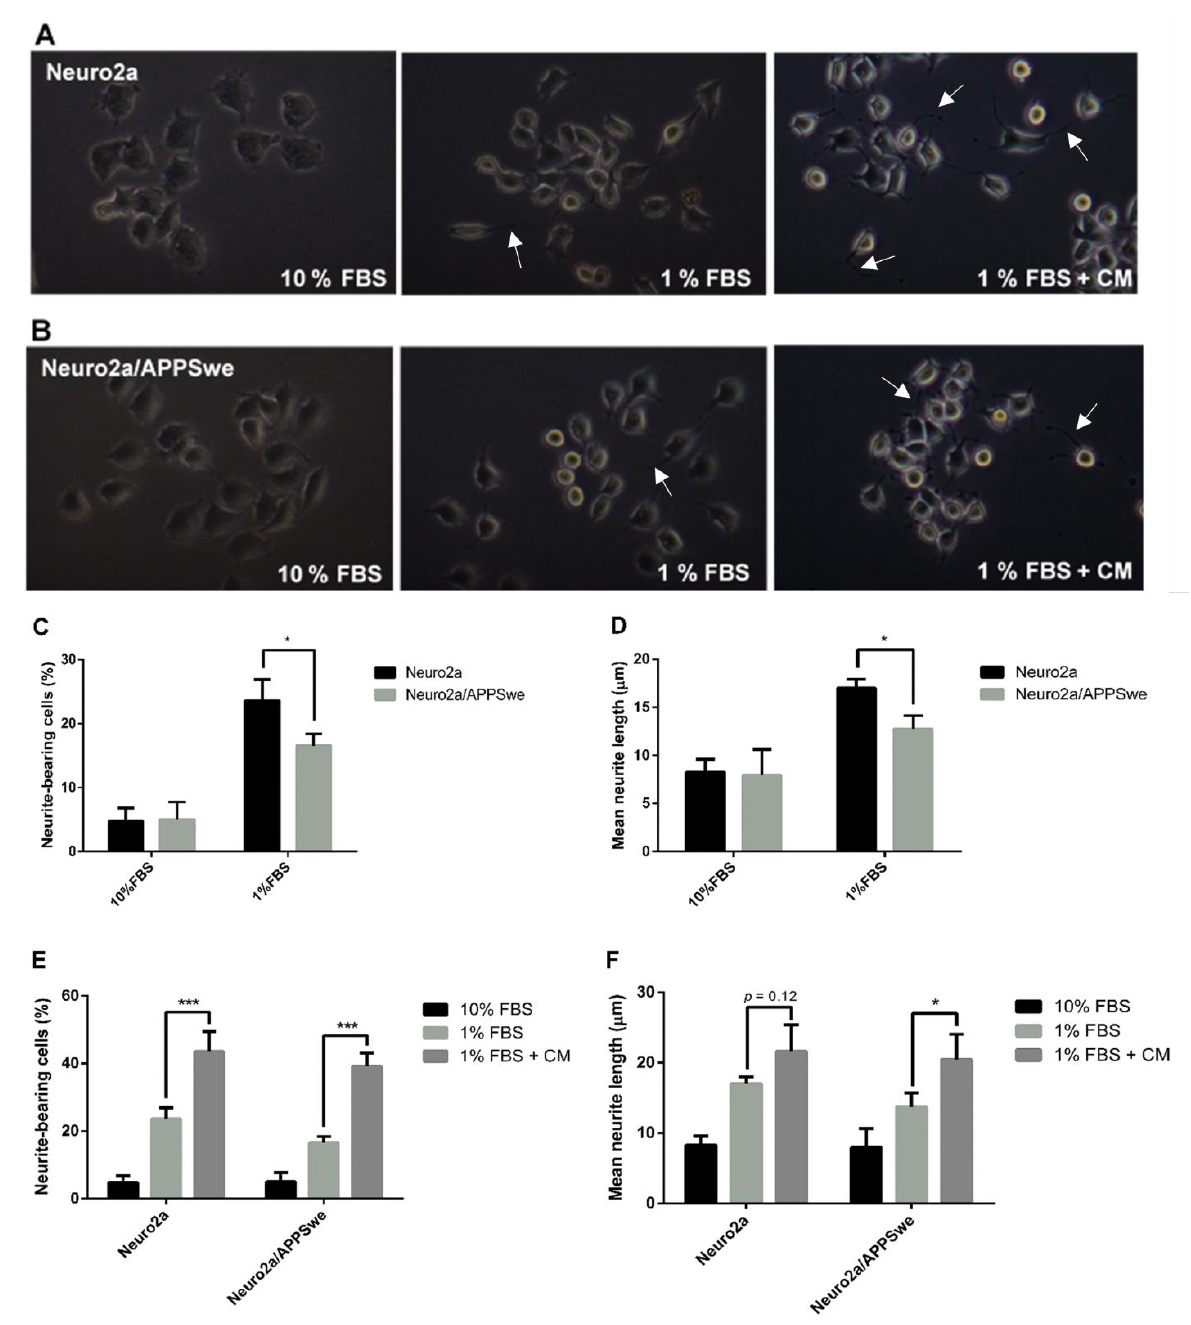
Figure 3. Neurite outgrowth determination. The neuronal morphology of ( A ) Neuro2a cells. ( B ) Neuro2a/APPSwe cells. Neuro2a/APPSwe cells exhibited number of ( C ) neurite-bearing cells and ( D ) neurite length significantly lower than Neuro2a cells after induced differentiation by 1% FBS medium for 48 h. When treated with 10 µg/mL CM extract for 48 h, Neuro2a and Neuro2a/APPSwe cells significantly increased both number of ( E ) neurite-bearing cells and ( F ) neurite length when compared with 1% FBS treatment. The white arrow indicates neurite. Values are mean ± SD of at least three independent experiments. * p- value < 0.05, *** p- value < 0.001.